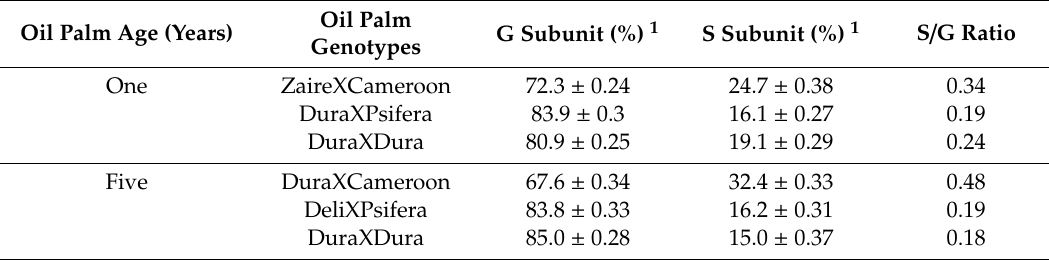
Table 2. The nitrobenzene oxidation products in oil palm root tissues expressed as. syringyl (S) and guaiacyl (G) subunit.